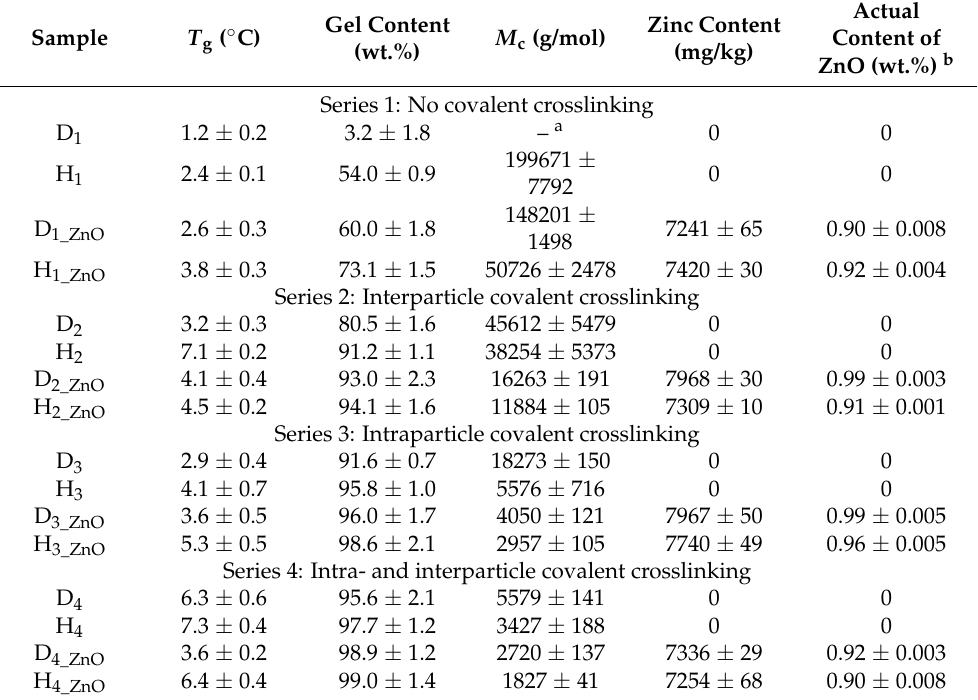
Table 7. Characteristics of coating materials prepared from latexes, differing in the covalent crosslinking strategy, surfactant type and nanostructured ZnO addition, in terms of T g , gel content and crosslink density, expressed as the average molecular weight between crosslinks ( M c ), and Zinc